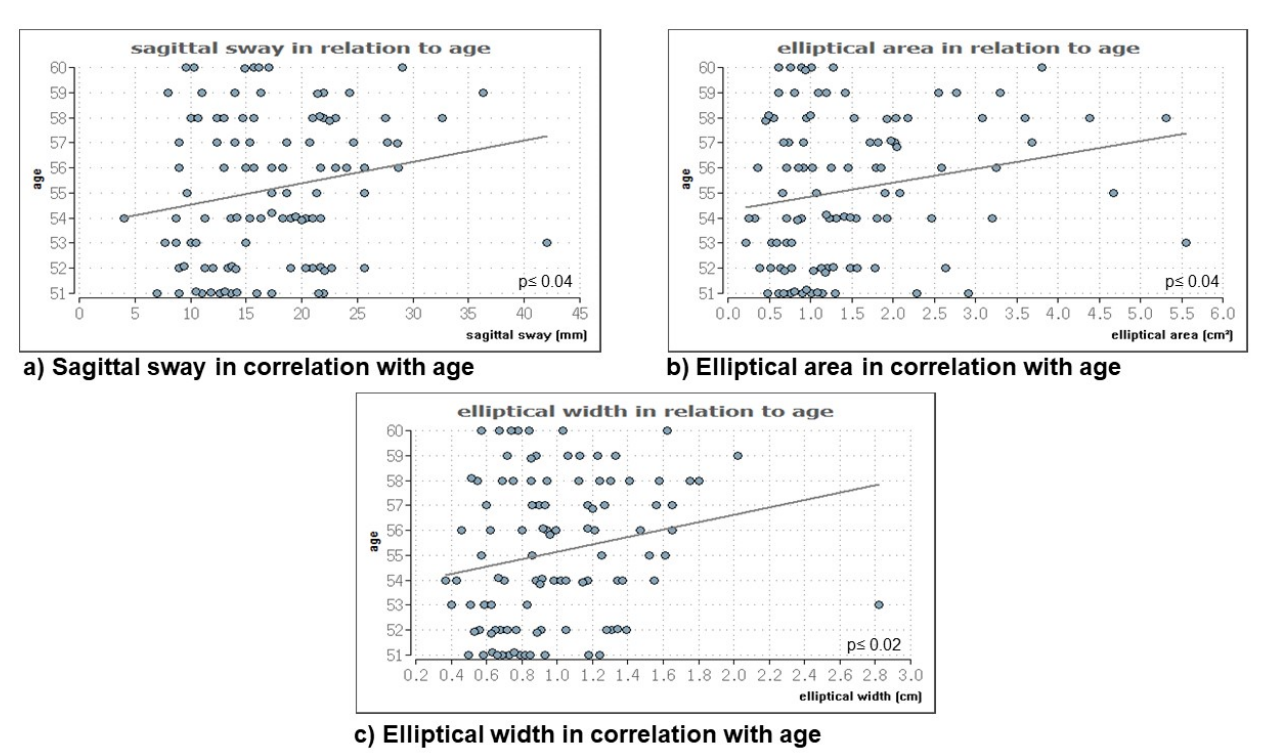
Figure 2. ( a ) Sagittal sway in correlation with age, ( b ) elliptical area in correlation with age, ( c ) elliptical width in correlation with age. The significant p -value is given in the respective graph.